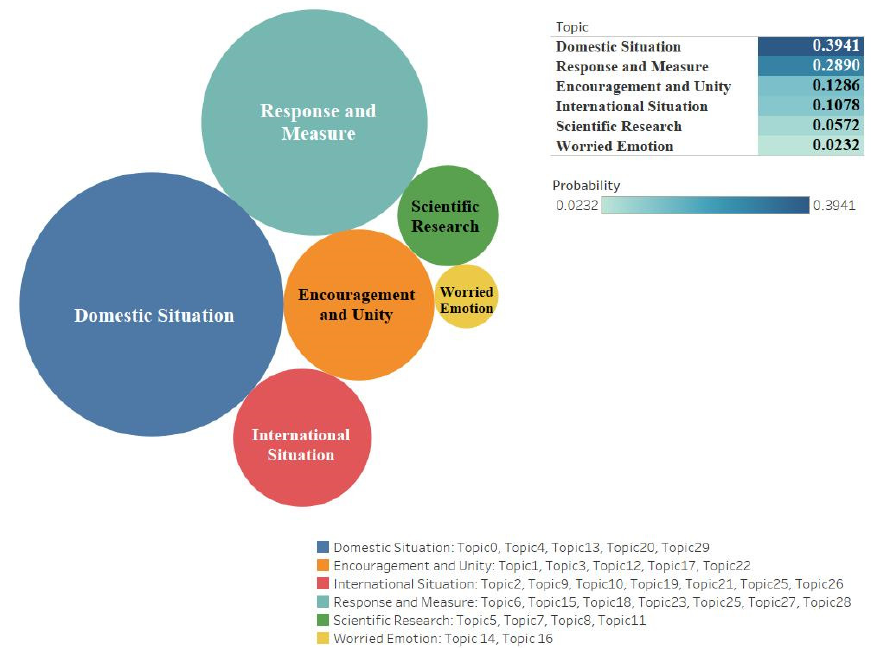
Figure 2. Clustering the topical issues, corresponding topics, and values of Weibo.